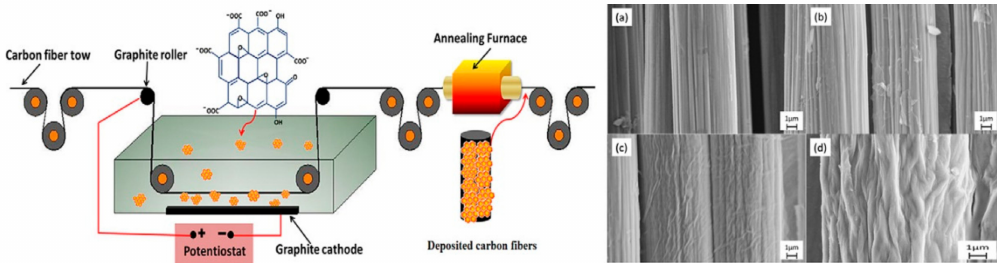
Figure 8. Schematic illustration of the electrophoretic deposition method for coating graphene oxide onto carbon fiber and ( a – d ) SEM images to show the results of EPD deposition at different voltages and current values. Reprinted with permission from [71]. Copyright 2012 Elsevier